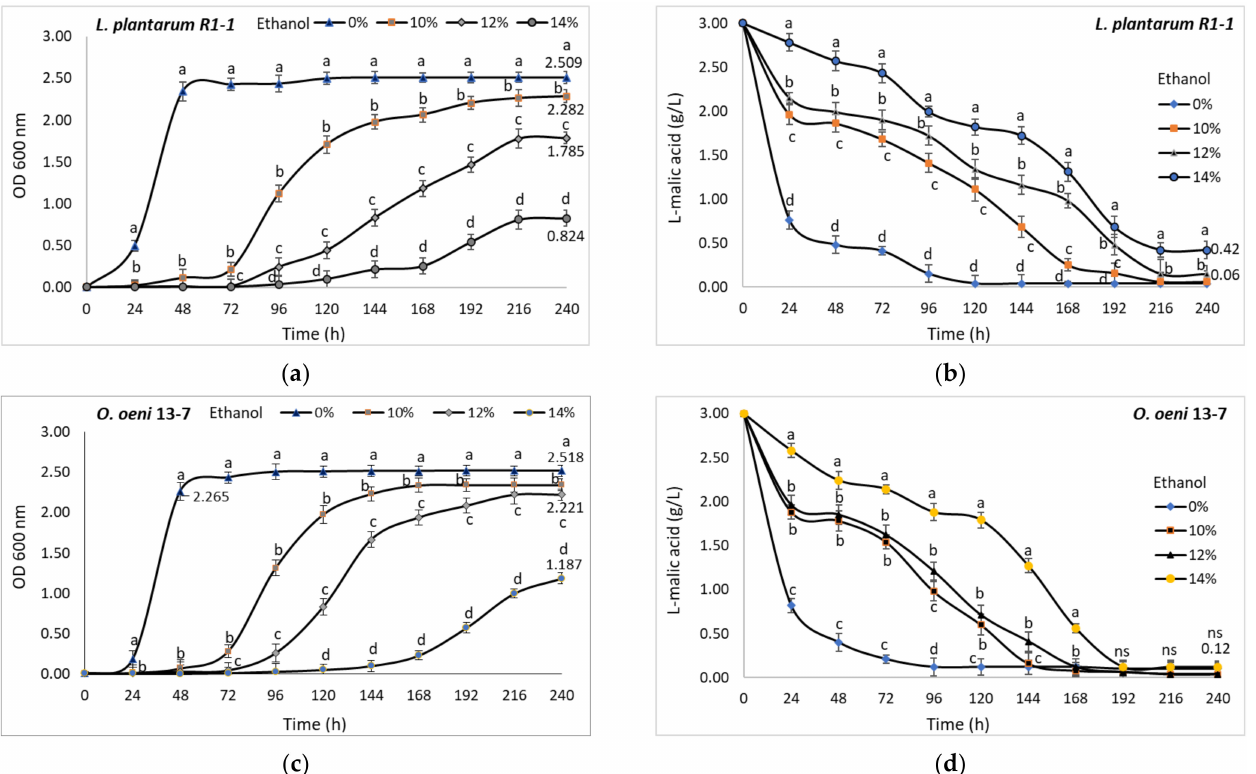
Figure 10. Influence of ethanol concentration on cell development and malic acid metabolism of Lactobacillus plantarum strain R1-1 ( a , b ) and Oenococcus oeni strain 13-7 ( c , d ). Cells incubated in MRS- TJ broth (10 6 CFU/mL) at 28 ◦ C. Each value is the mean of a triplicate experiment; error bars indicate standard deviation ( ± ). In all cases the standard deviation was lower than 10% of the mean value. Different letters within the same column indicate significant differences between data ( p <